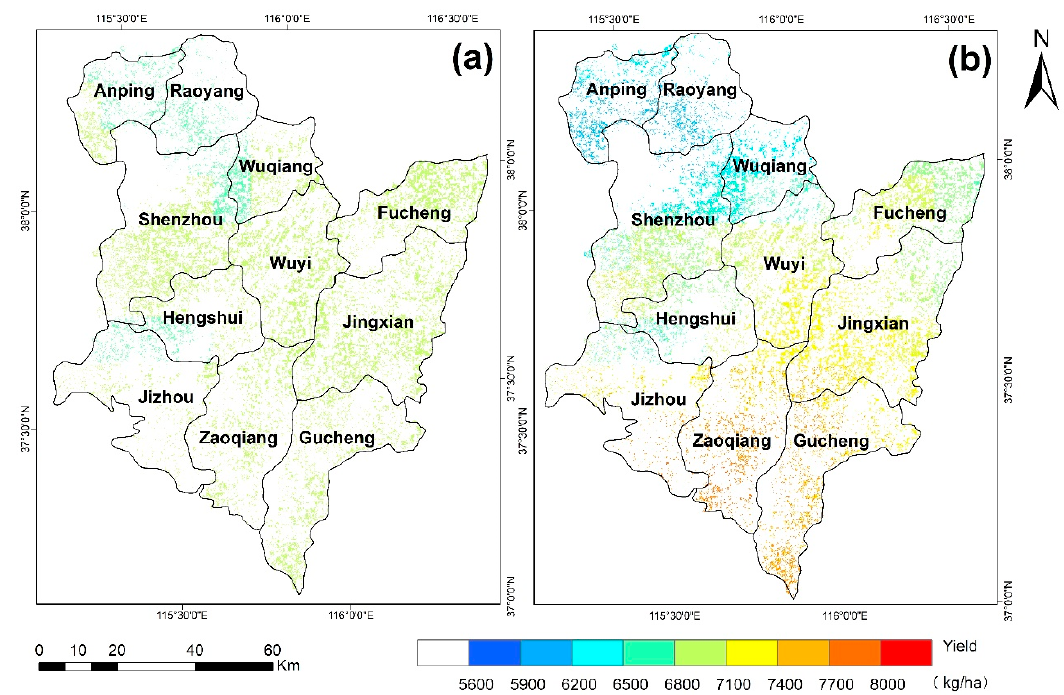
Figure 7. Regional winter wheat yield estimation without and with the EnKF assimilation method (( a ) without assimilation; ( b ) with EnKF assimilation).